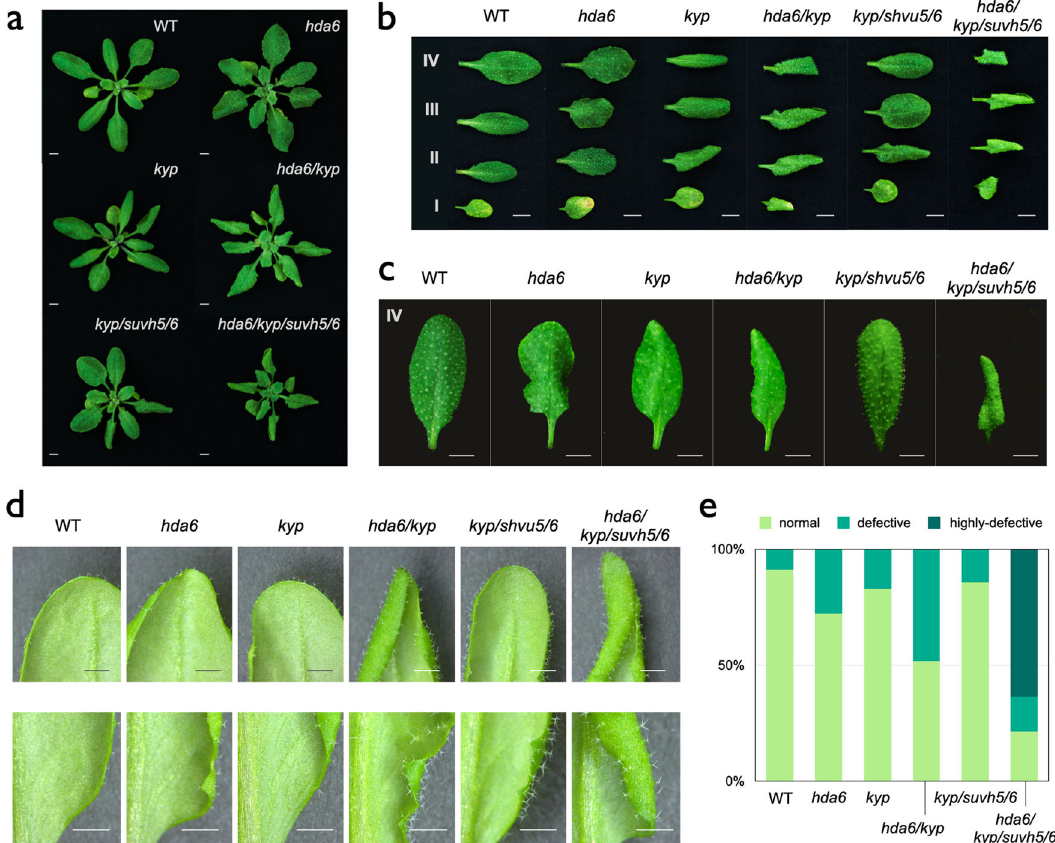
Fig. 1 Arabidopsis KYP, SUVH5 and SUVH6 are involved in leaf development. a – d Leaf development phenotypes of WT, hda6, kyp, hda6/kyp, kyp/suvh5/ 6 and hda6/kyp/suvh5/6 mutant plants. Plants were grown under long-day for 20 days. I, II, III, and IV indicate the fi rst, second, third, and fourth pair of leaves, respectively. Bars = 5 mm ( a – c ) or 2 mm ( d ). e Quantitative analysis of leaf development phenotypes of WT, hda6, kyp, hda6/kyp, kyp/suvh5/6 and hda6/kyp/suvh5/6 plants. The fourth pair rosette leaves were classi fi ed as normal, defective and highly-defective leaves. The ratio of defective and total leaves was calculated. At least 40 leaves for each line were